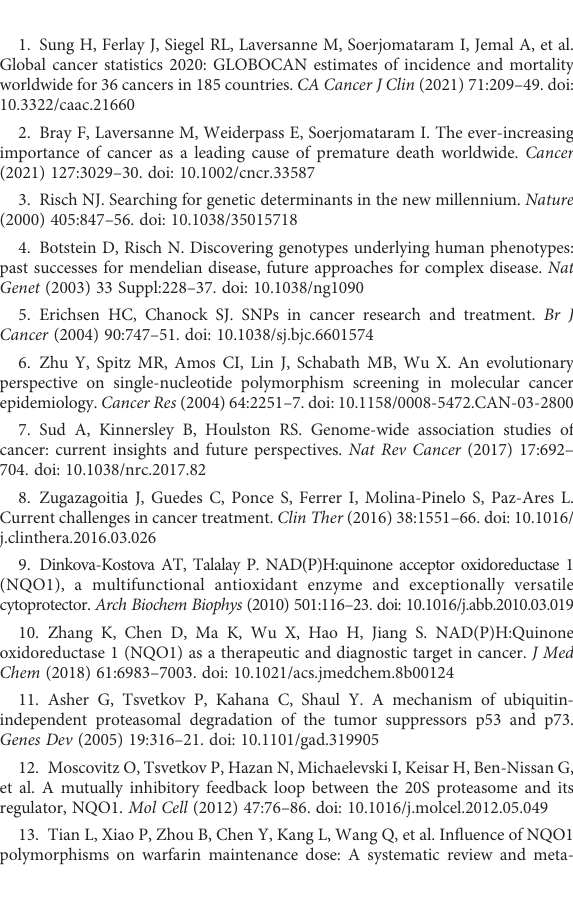
SUPPLEMENTARY FIGURE 1 (A) The MAF for the NQO1 rs1800566 polymorphism from the online